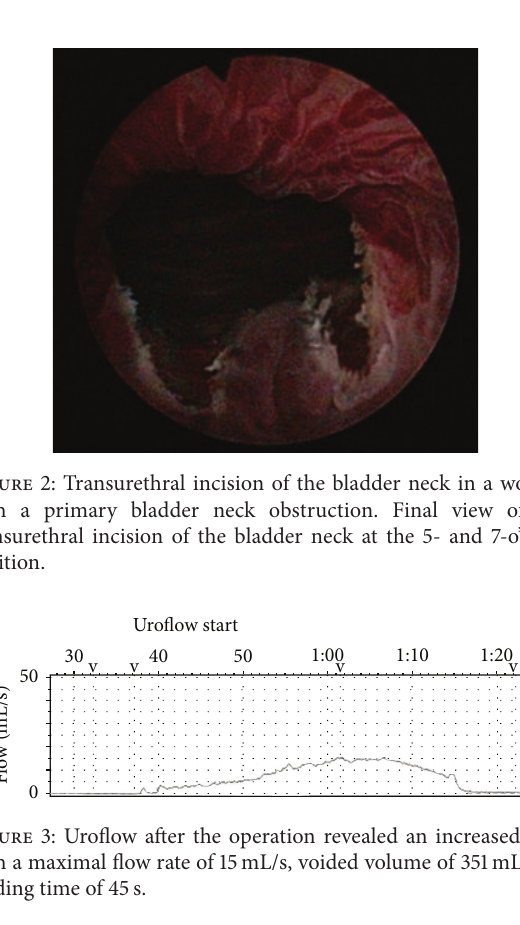
Figure 1: Uroflow before the operation revealed an obstructed flow with a maximal flow rate of 9mL/s, voided volume of 397 mL, and voiding time of more than 2 minutes.